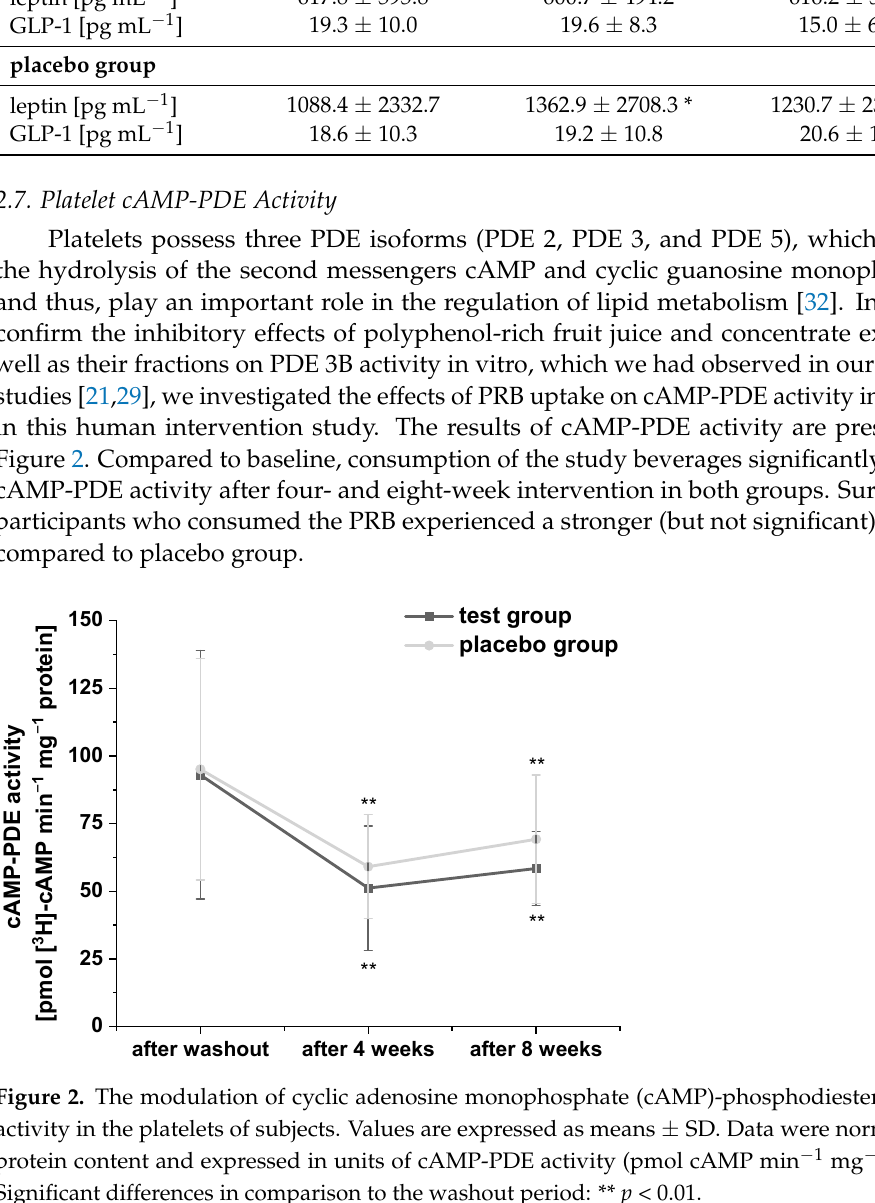
** Figure 3. The plasma uric acid concentrations after the washout period, after four and eight weeks of intervention. Data are expressed as means ± SD. Significant differences in comparison to the washout period: ** p < 0.01. 2.9. DNA Strand Breaks (Comet Assay) The modulation of background and total DNA strand breaks was assessed in whole blood. Additionally, to monitor alterations in cell sensitivity to reactive oxygen spe- cies-induced DNA damage, the total DNA strand breaks in PBLs were analyzed after